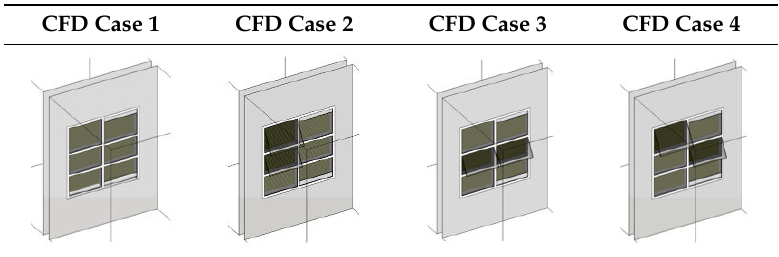
Table 13. Cases for